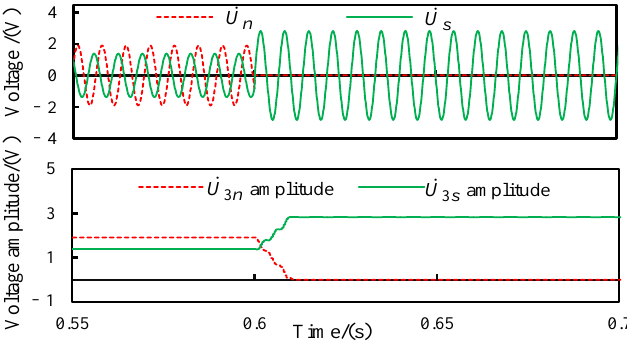
Figure 13. The third harmonic voltage of when a metal ground fault occurs at a generator’s neutral point.